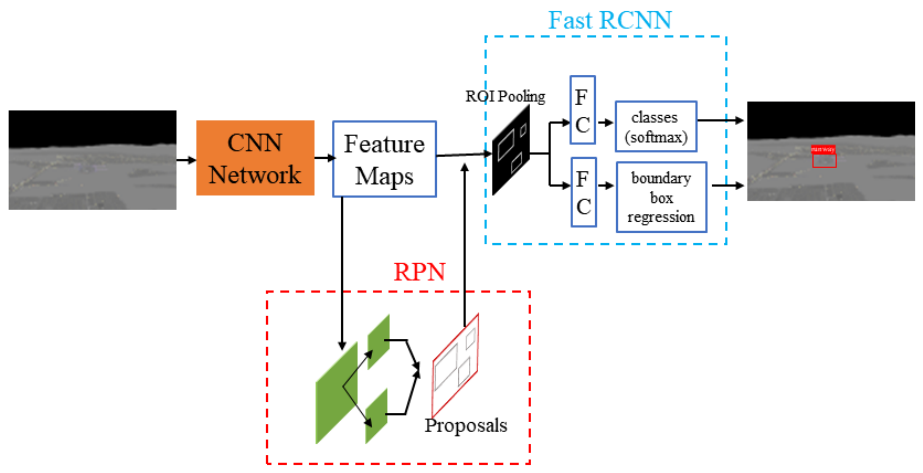
Figure 3. Faster R-CNN structure.